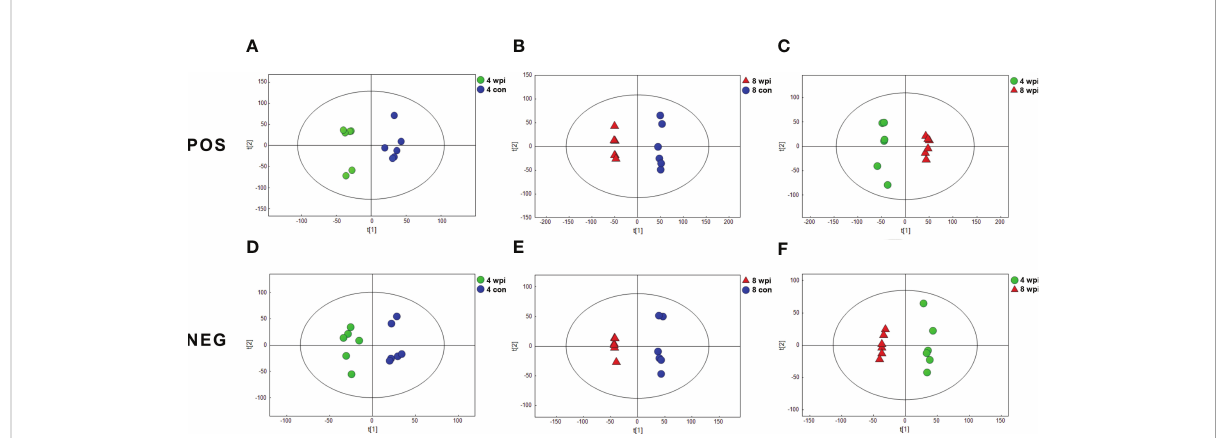
FIGURE 1 Orthogonal partial least-squares discriminant analysis (OPLS-DA) score plots showing the separation between C. sinensis -infected and control groups at 4 and 8 wpi in ESI+ mode (A-C) and ESI − mode (D-F) . The ellipses enclose the 95% con fi dence intervals estimated by the sample means and covariances of each group.